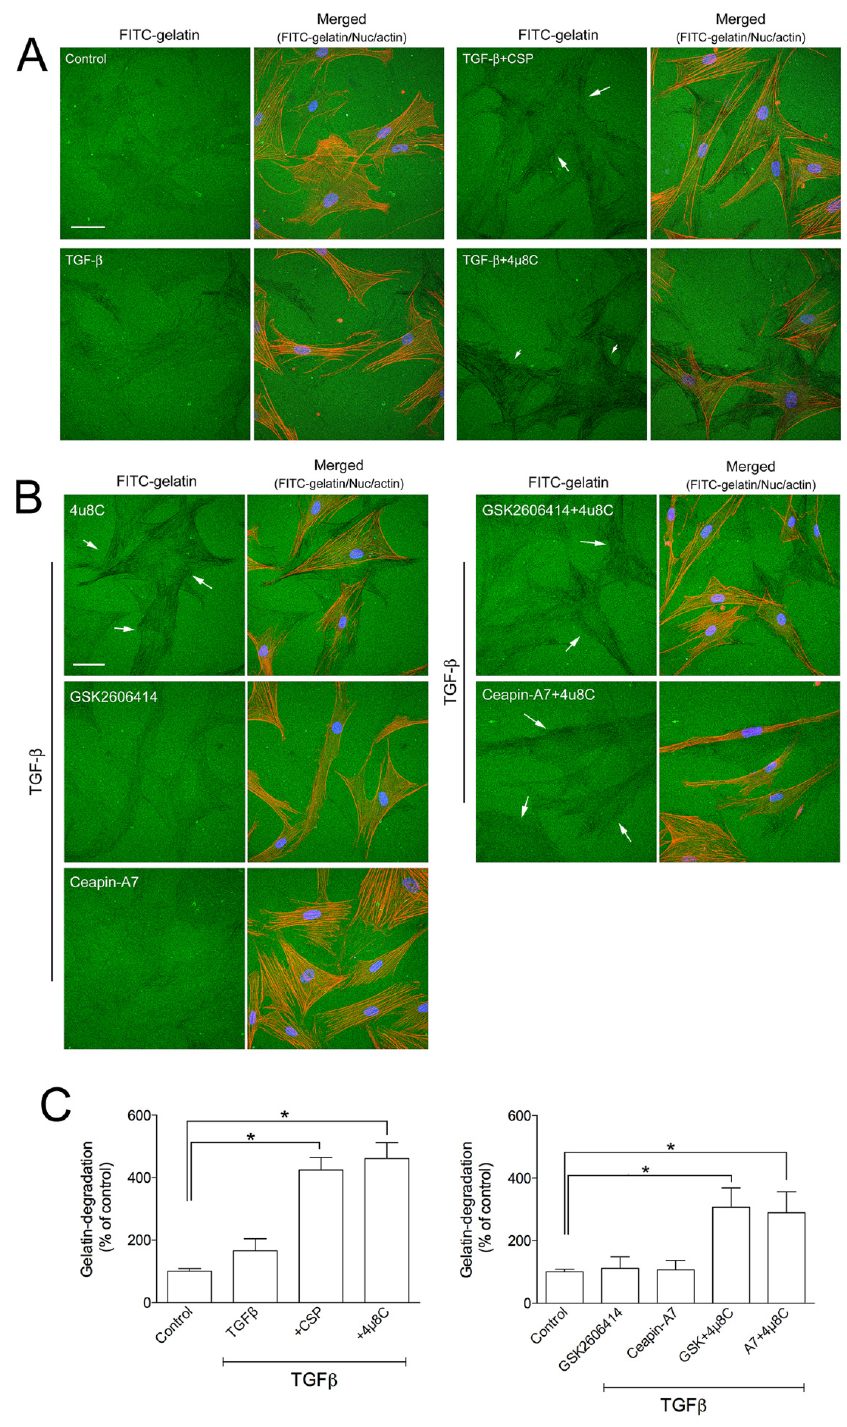
Figure 5. Effects of ER stress inhibitors on hIPF-Lfs gelatin degradation activity. hIPF-Lfs were seeded on glass coverslips coated with FITC-conjugated gelatin (green) under serum-starved conditions. After 18 h incubation, cells were treated with ( A ) CSP (20 µ M), 4 µ C8 (25 µ M), ( B ) 4 µ C8 (25 µ M), GSK260641 (1 µ M), and Ceapin-A (10 µ M) in the presence or absence of TGF β for 48 h. These cells were then fixed and stained with nuclear (blue) and F-actin (red). Scale bars: 50 µ m. Arrows indicate degradation areas. ( C ) The gelatin degradation was quantified by measuring the degraded areas using the NIH image program. Values are means ± SEM from three independent experiments. The degradation area of serum-starved cells was determined as a control of reference. p * values by one-way ANOVA with the Dunnett’s multiple comparisons test ( p <